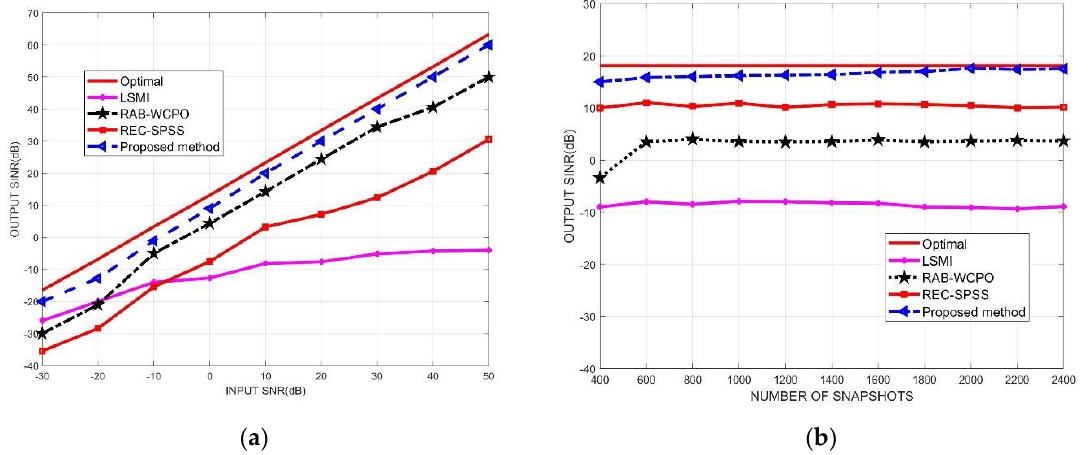
Figure 6. Output SINR of array antenna versus input SNR and number of snapshots, respectively. ( a ) output SINR versus input SNR; ( b ) output SINR versus number of